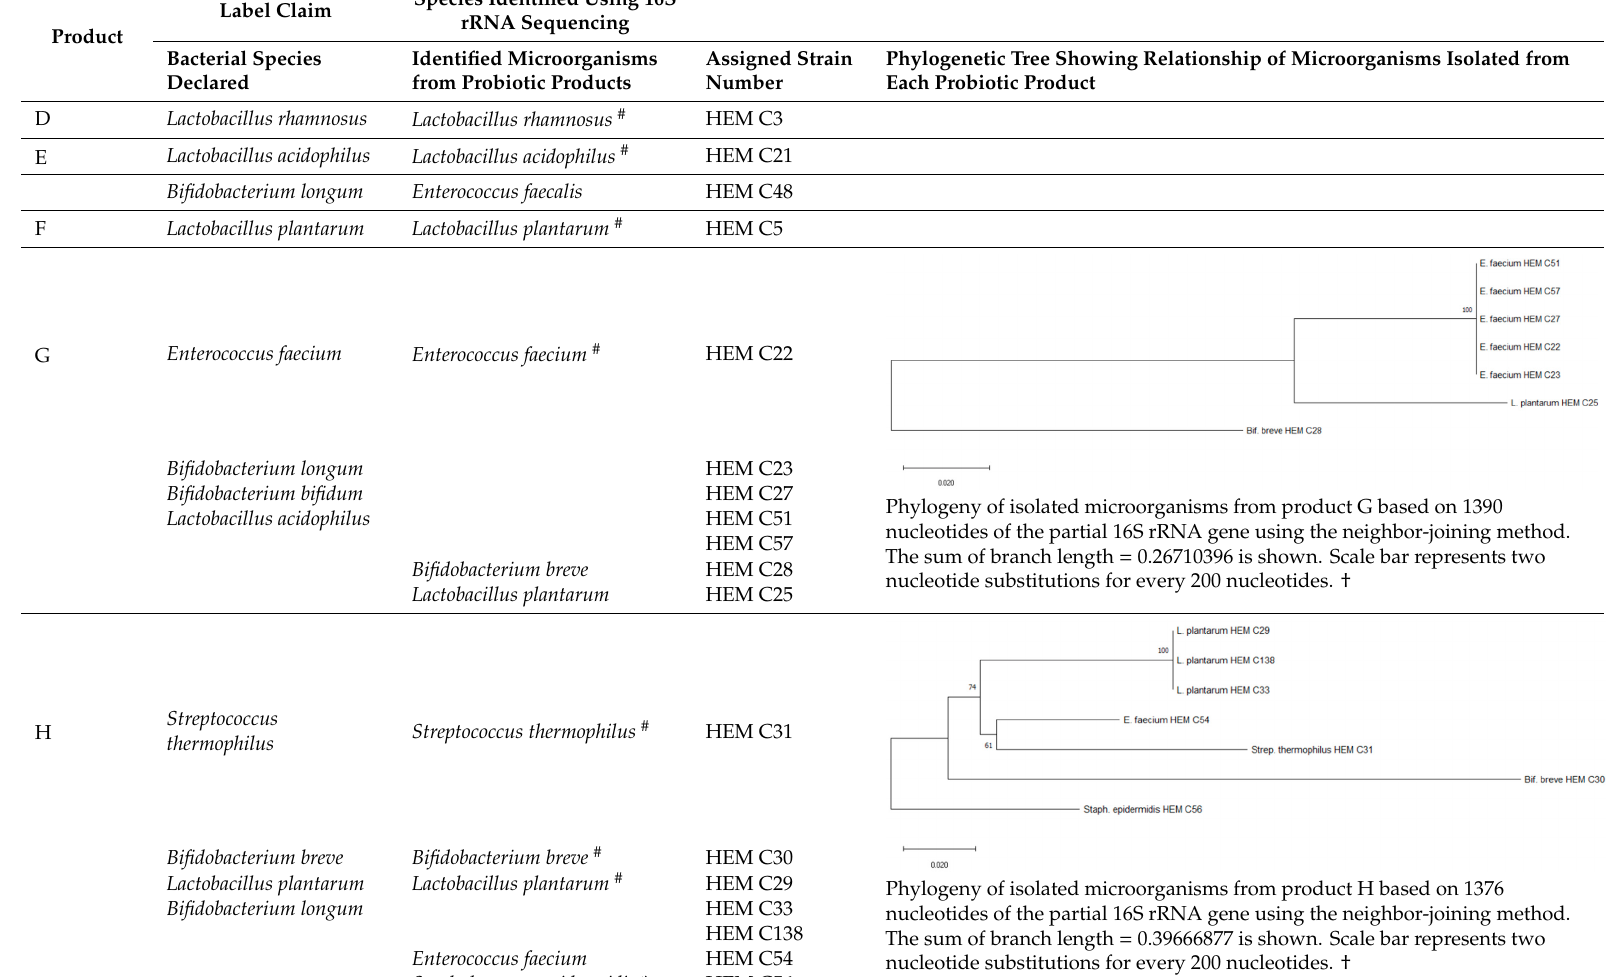
Phylogenetic Tree Showing Relationship of Microorganisms Isolated from Each Probiotic Product